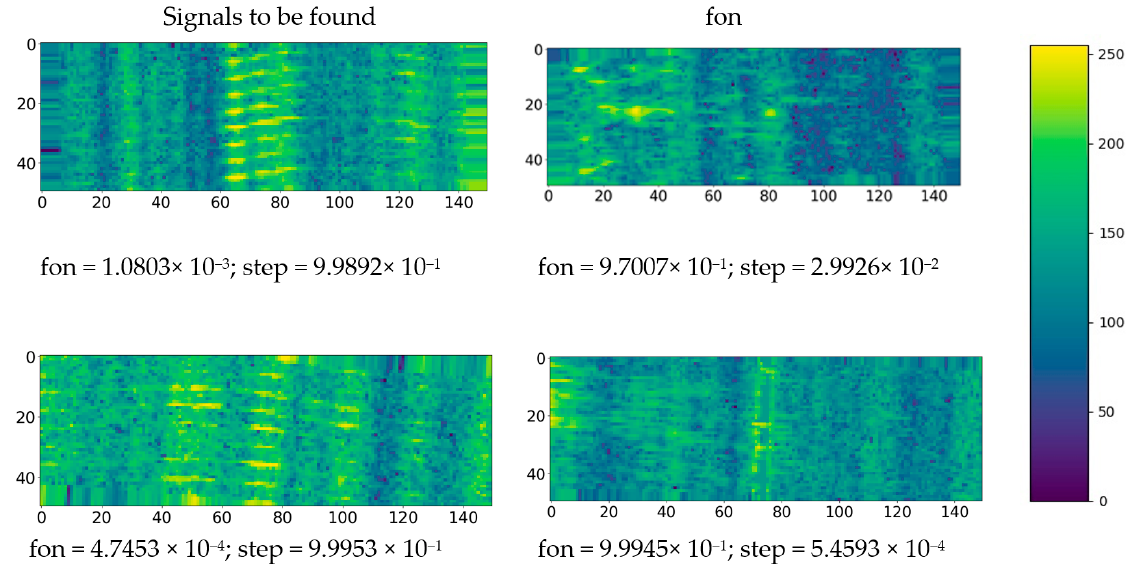
Figure 15. Example results of the created classifier on some data (grayscale images).